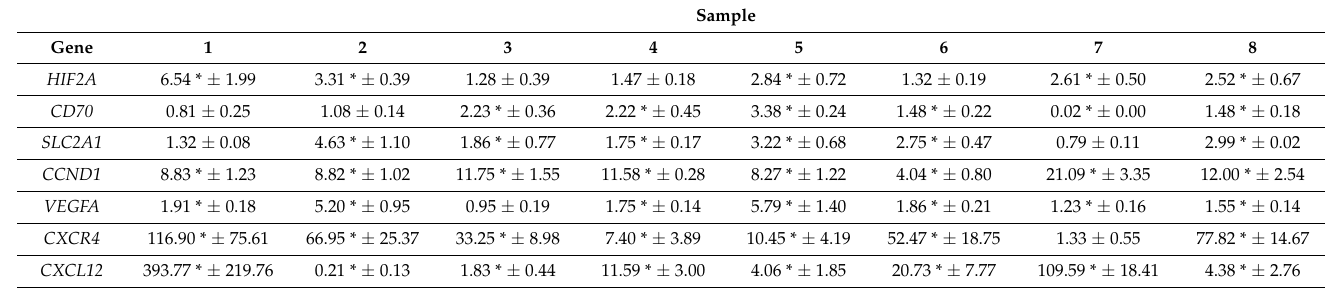
Table 2. Patient-derived ccRCC cells with higher HIF2 α -related gene expression compared to HK- 2 cells. Gene N (%) HIF2A 5/8 (63%) CD70 5/8 (63%) SLC2A1 5/8 (63%) CCND1 8/8 (100%) VEGFA 7/8 (88%) CXCR4 7/8 (88%) CXCL12 7/8 (88%) p < 0.05. Table 3. mRNA expression of individual ccRCC samples, normalized to HK-2 cells.